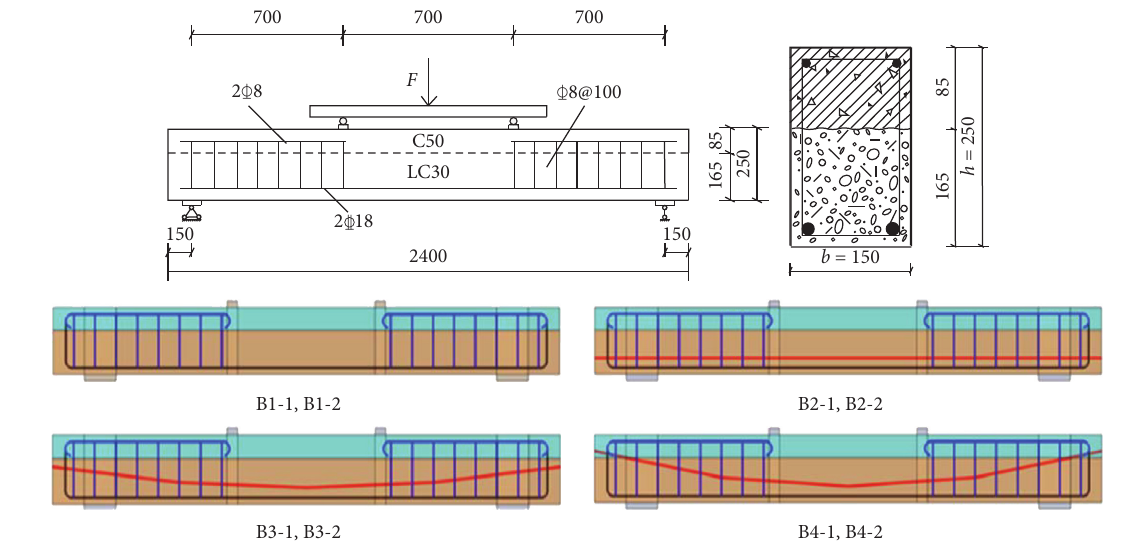
Figure 1: Scheme of the superposing-poured beam model. Table 1: Description of the superposing-poured beam model.